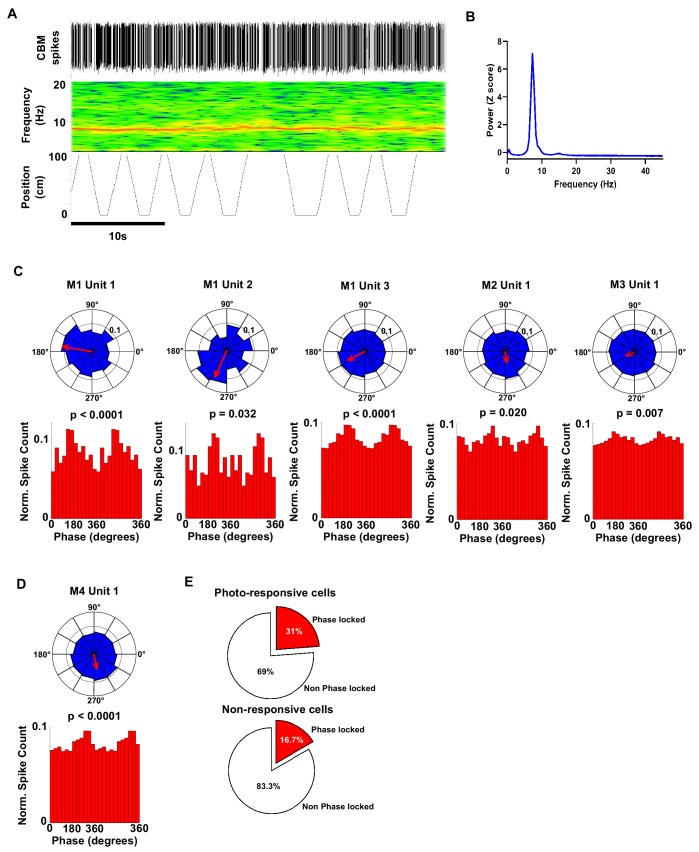
Polar plots and associated histograms of cerebellar units significantly phase locked to hippocampal 6–12 Hz oscillations.(A) Example 40 s epoch used for analysis of phase locking. Top, detected cerebellar spikes. Middle, hippocampal spectrogram. Bottom, position tracking in virtual reality corridor. (B) Hippocampal power spectra calculated from the epoch shown in A. Note the prominent theta peak (~8 Hz). (C) Individual polar plots and phase distribution histograms for each photo responsive unit (five cells from three mice) that were significantly phase locked to the hippocampal 6–12 Hz oscillation. (D) Polar and phase distribution plots for the single non-responsive unit recorded that was significantly phase locked to hippocampal 6–12 Hz oscillation. P Rayleigh value for each cell plotted above histogram. (E) Pie charts showing the % of photo-responsive (upper) and photo non-responsive units (lower) that were phase locked to the hippocampal 6–12 Hz oscillation. From our sample, 31% (5 from 16 units) of photo-responsive units and 16% of non-responsive units were phase locked to the hippocampal 6–12 Hz oscillation, respectively.